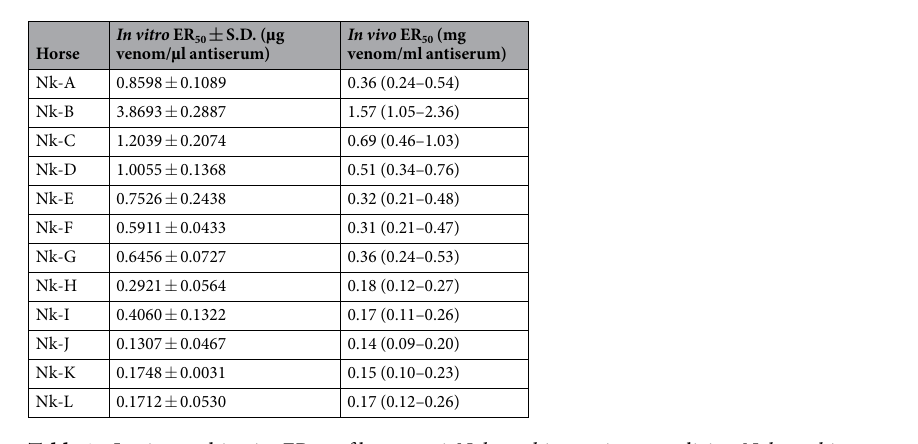
Table 1. In vitro and in vivo ER 50 s of horse anti- N. kaouthia sera in neutralizing N. kaouthia venom. For each batch of antiserum, the in vitro ER 50 was mean ± S.D. from 4 determinations while the in vivo ER 50 was median ± 95% C.I. (C.I. = confidence level).